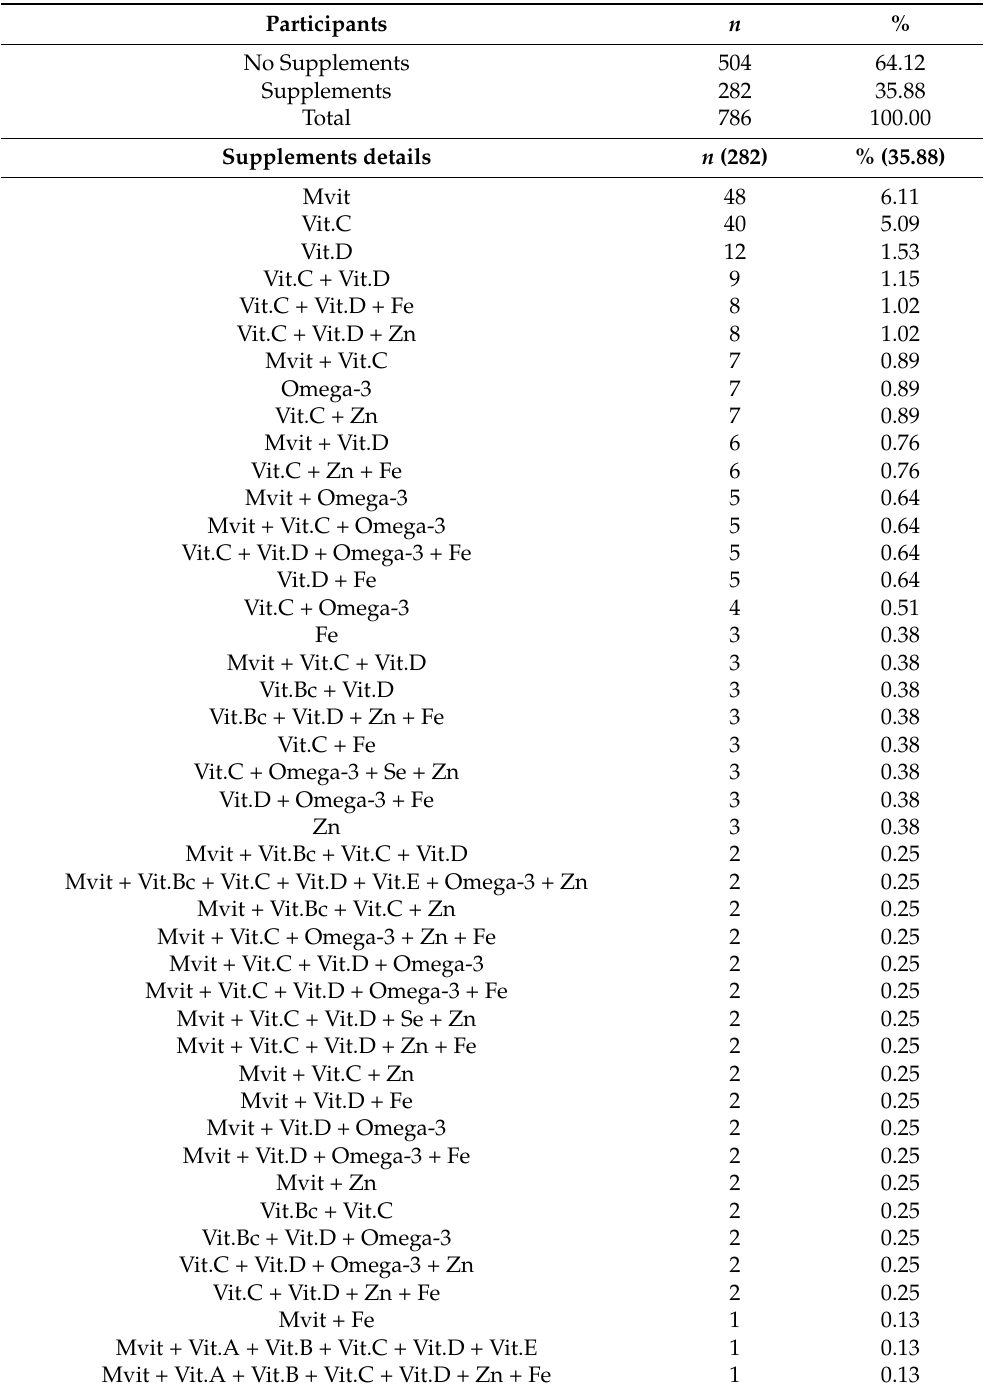
Table 4. Taken supplements by the participants during the COVID-19